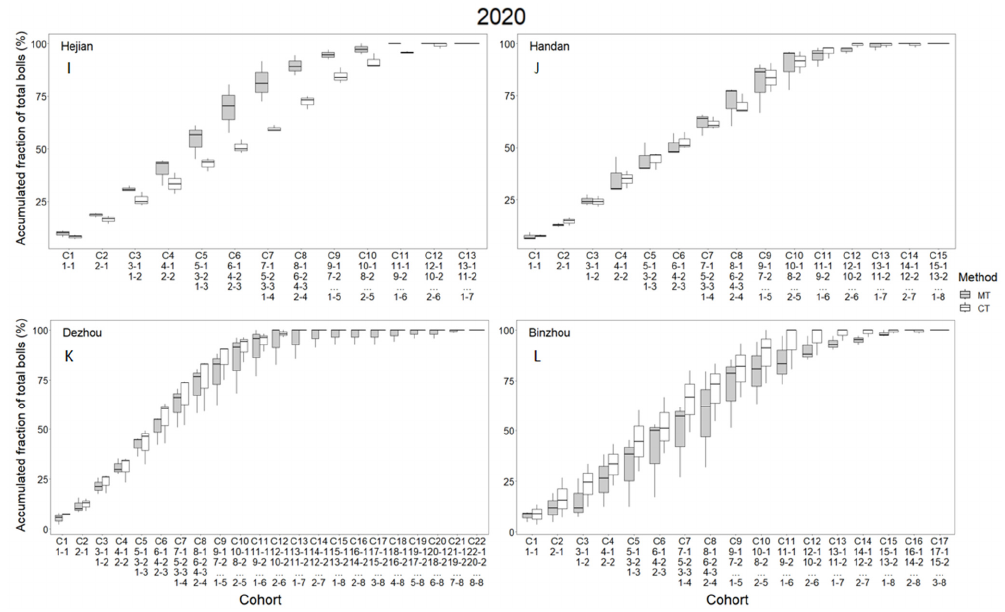
Figure 5. Effect of topping treatments during flowering on accumulated boll fraction by cohort ( C ) at Hejian ( A , E , I ) and Handan ( B , F , J ), Hebei Province, and Dezhou ( C , G , K ) and Binzhou ( D , H , L ), Shandong Province in 2018 ( A – D ), 2019 ( E – H ) and 2020 ( I – L ). Each cohort includes fruiting sites blooming simultaneously. 1-1 means the first fruiting position on the first fruiting branch, and so on. MT and CT indicate manual topping and chemical topping, respectively.